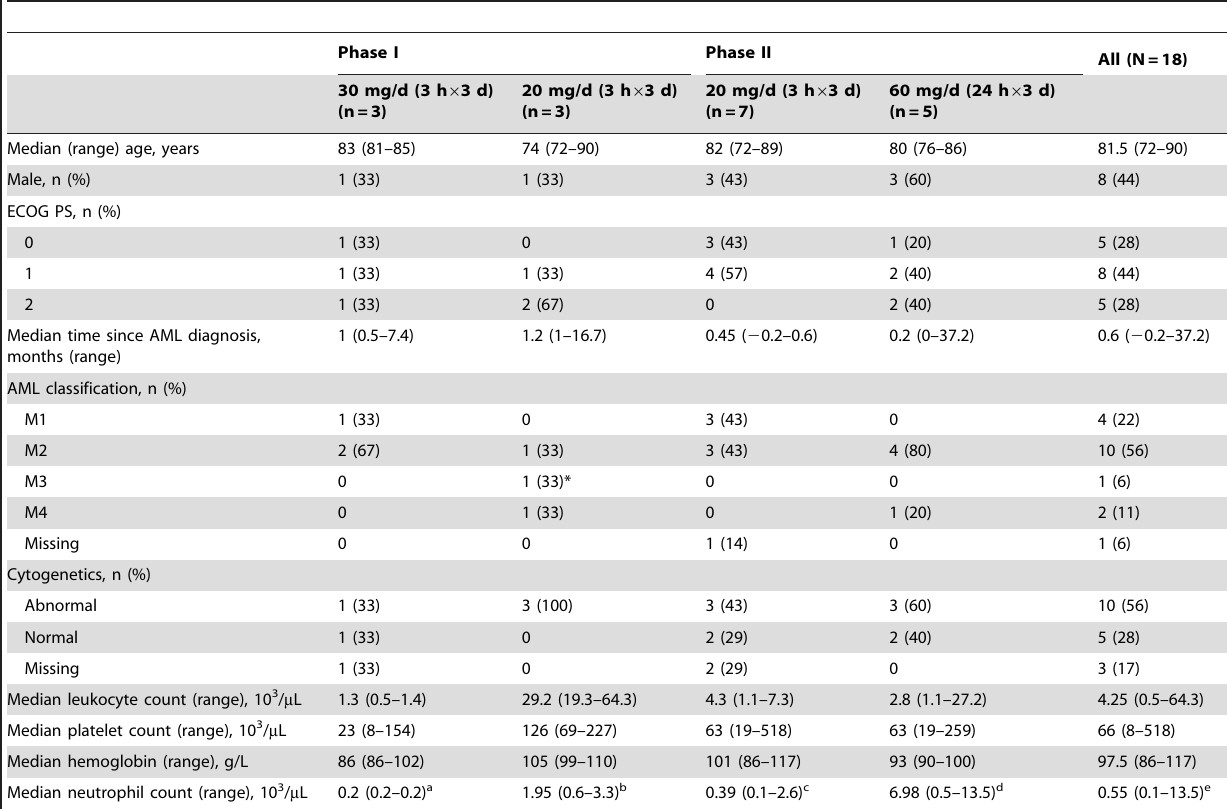
Table 1. Demographics and baseline characteristics of obatoclax-treated patients (N